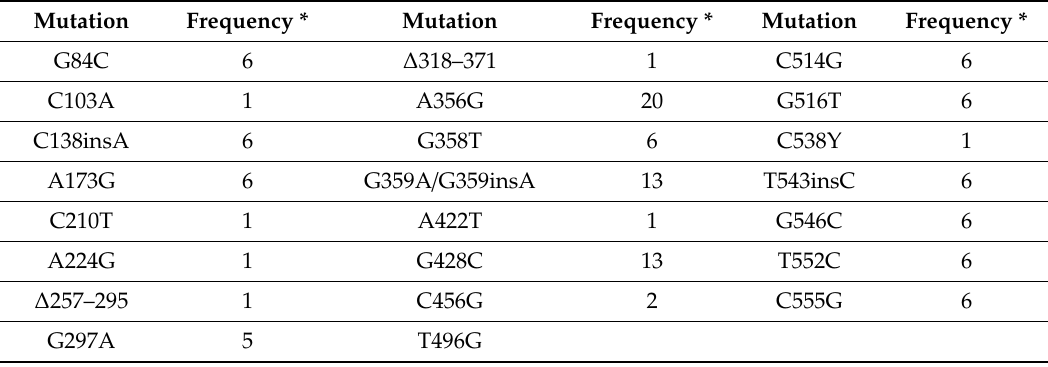
Figure 7. Mutations and their prevalence in variants of Trichodisplasia spinulosa polyomavirus (TSPyV) noncoding control region (NCCR). The numbering of the NCCR is from early to late with nucleotide 1 being the most proximal to the ATG start codon of the early genes and the most distal nucleotide, just upstream of the start codon of the VP2 gene. The number of times a peculiar mutation is found in the di ff erent variants is given as frequency (with n the number of times the mutation was described / total NCCR variant sequences available). Putative Large T antigen (LT) binding motifs 5 ′ - GRGGC-3 ′ ( → ) or 5 ′ -GCCYC-3 ′ ( ← ) are shown. The table summarizes the mutations, their location in the NCCR, and their frequency. For details see Table S1. Putative transcription factor binding sites are shown in Supplementary Table S2. Table 9. Frequency of mutations in the noncoding control region of Trichodisplasia spinulosa polyomavirus.